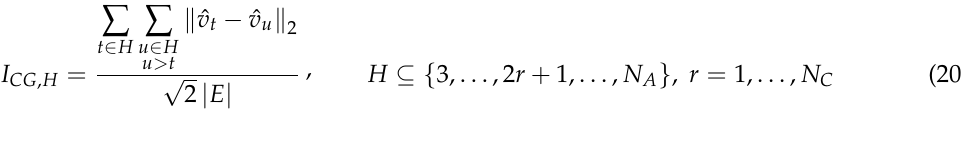
K 2 (cid:16) (cid:17) blue dotted lines constitute the edges: ( a ) C H is the same as Figure 10a; ( b ) C H is the same as Figure